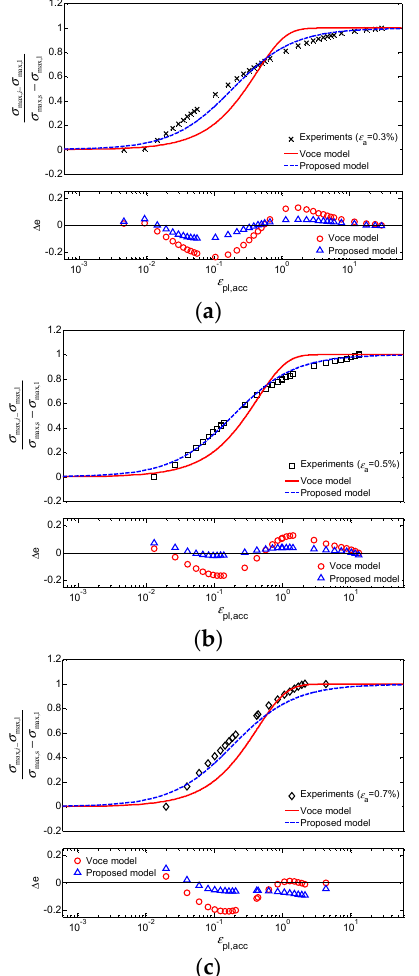
Figure 6. Isotropic model for different strain amplitudes (( a ) ε a = 0.3%, ( b ) ε a = 0.5% and ( c ) ε a = 0.7%) calculated with b all , a all and s all parameters; Voce model (red solid line) and proposed model (blue dashed line). Residual ∆ e is also reported. Table 1. Isotropic parameters identified from experimental data for the Voce and proposed models. Goodness-of-fit examined in terms of sum of squares of residuals (SSE) for each model and strain amplitude.